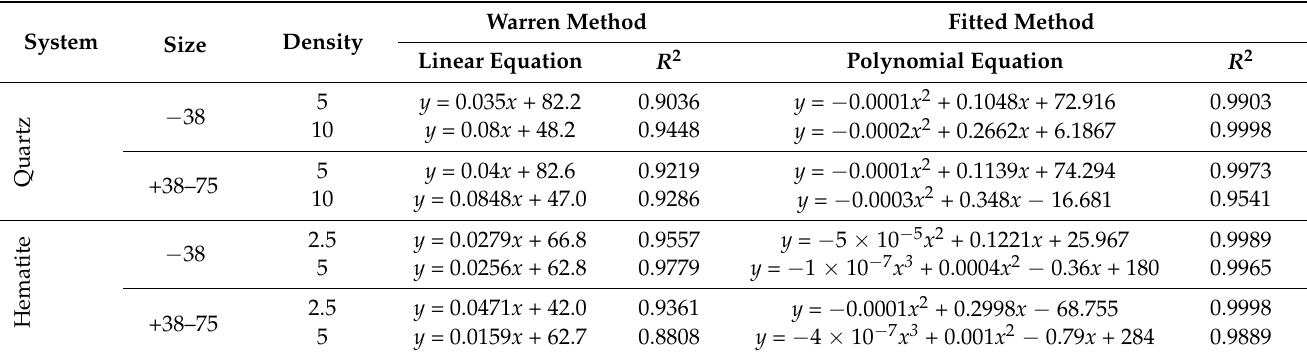
Table 4. Linear and polynomial fitting of entrainment.